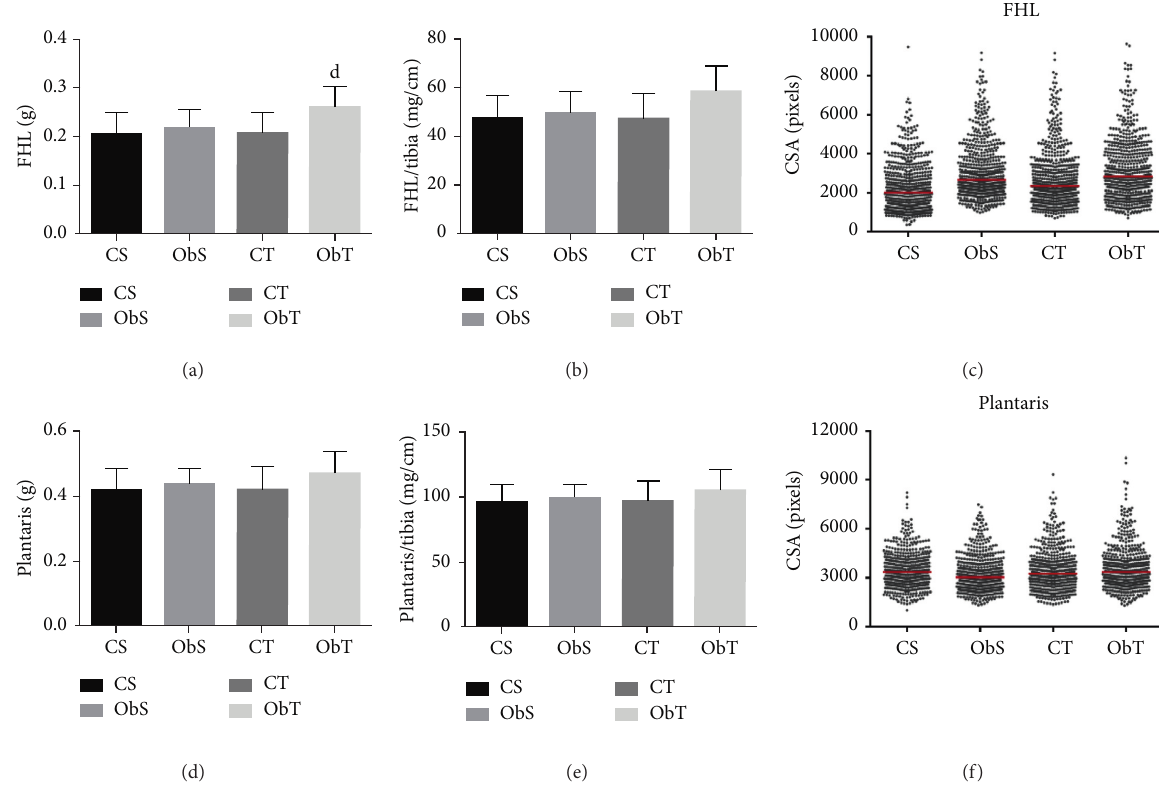
Figure 6: Morphometric parameters and histological sections of the flexor hallucis longus (FHL) and plantaris muscles. CS � sedentary control ( n � 5); CT � control submitted to the strength training protocol ( n � 5); ObS � sedentary obese ( n � 5); ObT � obese submitted